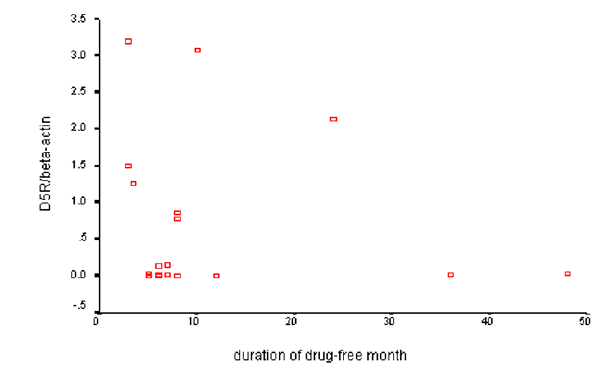
Figure 7 Relationship between D5R/ β A and drug-free duration in drug-free patients. In D5R/ β A, similar findings were shown with D3R/ β